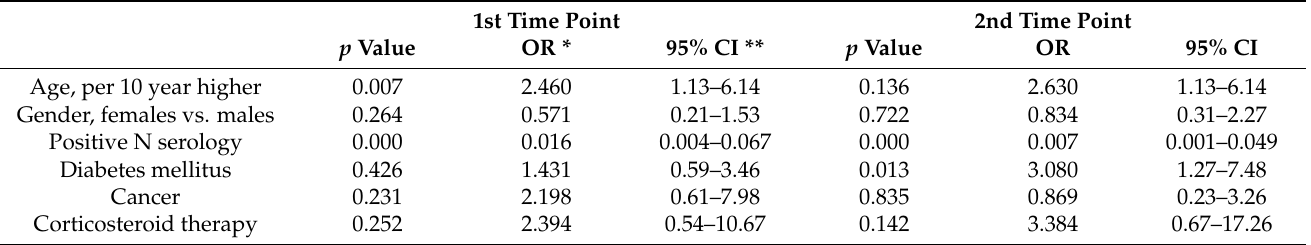
Table 1. Multivariable logistic regression analyses of the risk of suboptimal response to SARS-CoV-2 vaccination after 2 and 6 months in residents of a long-term care facility. 1st Time Point 2nd Time